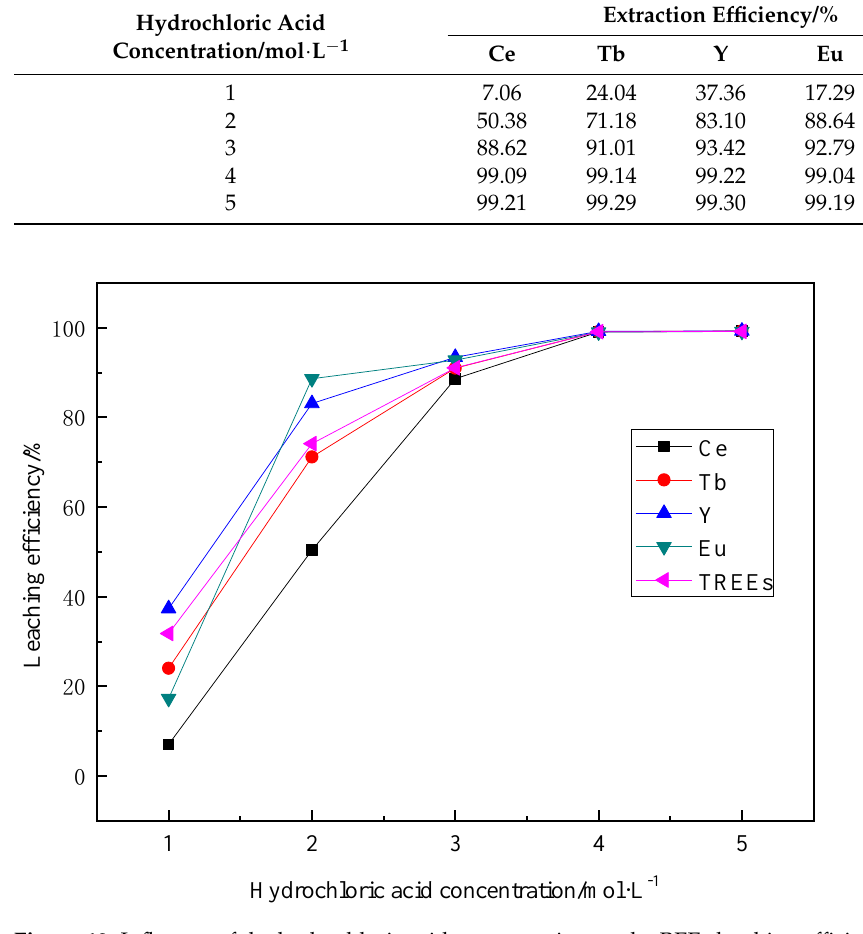
Figure 10. Influence of the hydrochloric acid concentration on the REEs leaching efficiencies (oxygen concentration in the mixed gas of 0.4%, roasting temperature of 700 °C, roasting time of 2.5 h, mass ratio of phosphor powder to alkali 1:3, acid leaching temperature of 60 °C, acid leaching time of 1 h, and liquid–solid ratio of 10:1).